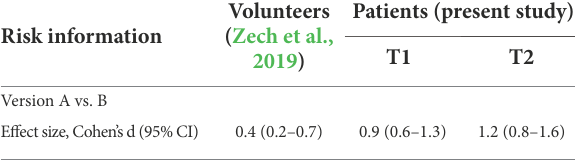
TABLE 6 Effectiveness of an alternative formulation of risk information to prevent weakening in healthy volunteers and in